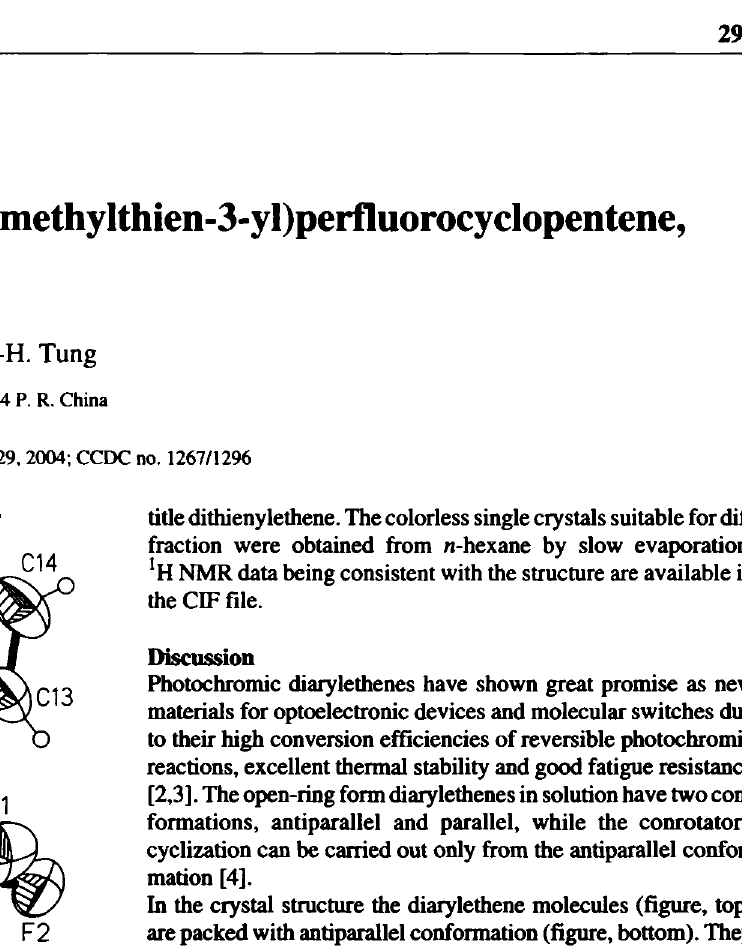
Table 1. Data collection and handling.